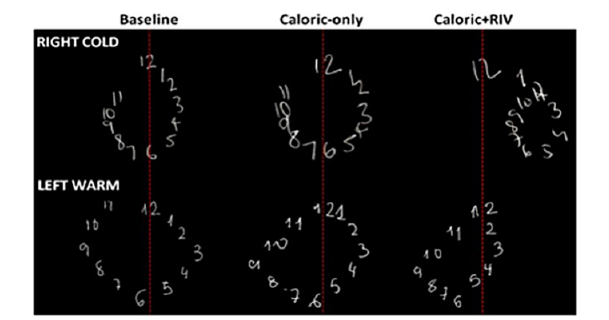
to draw numerical (magnitude-dependent, 1–12) or alphabetical (magnitude-independent, A–L) clock faces with their eyes closed.